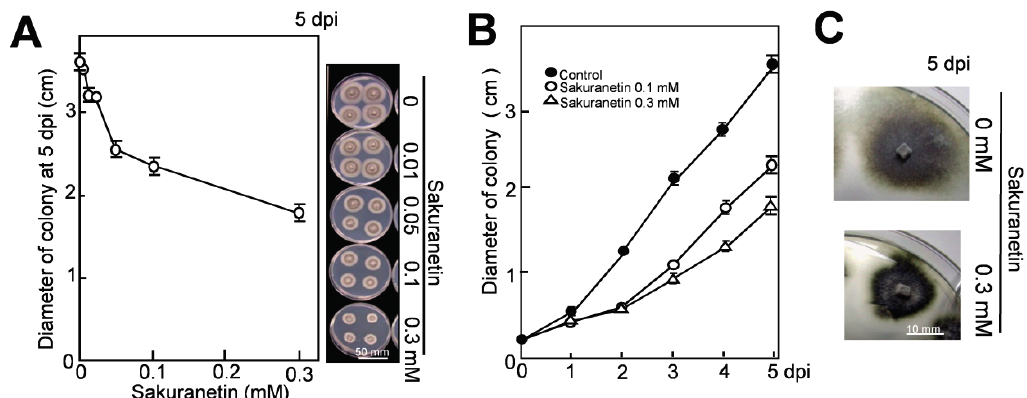
Figure 2. Inhibition of blast mycelium growth by sakuranetin on solid medium. ( A ) Size of blast mycelium colony on PDA containing sakuranetin at 5 dpi; ( B ) Time course analysis on the spread of blast mycelium colony on PDA containing sakuranetin at 0.1 or 0.3 Mm; ( C ) Phenotype of the mycelium colony with or without 0.3 mM sakuranetin at 5 dpi. Data are means ± SD from four independent samples. Scale bar in Figure 2A indicates 50 mm, and that in Figure 2C 10